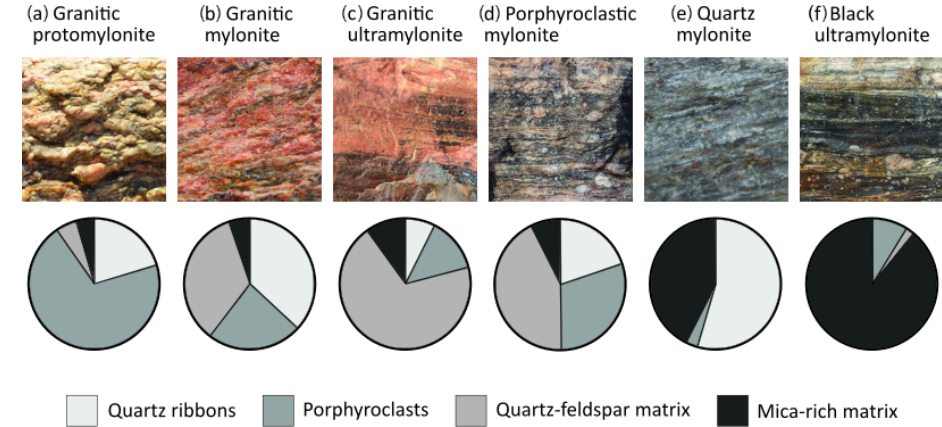
Figure 5. The six rock types which (with pegmatite) dominate the map area, with example photos and pie charts demonstrating the relative proportions of coarse grains (quartz ribbons and porphyroclasts) and fine matrix (divided into quartz–feldspar-rich and mica-rich). Each example photo has a field of view of